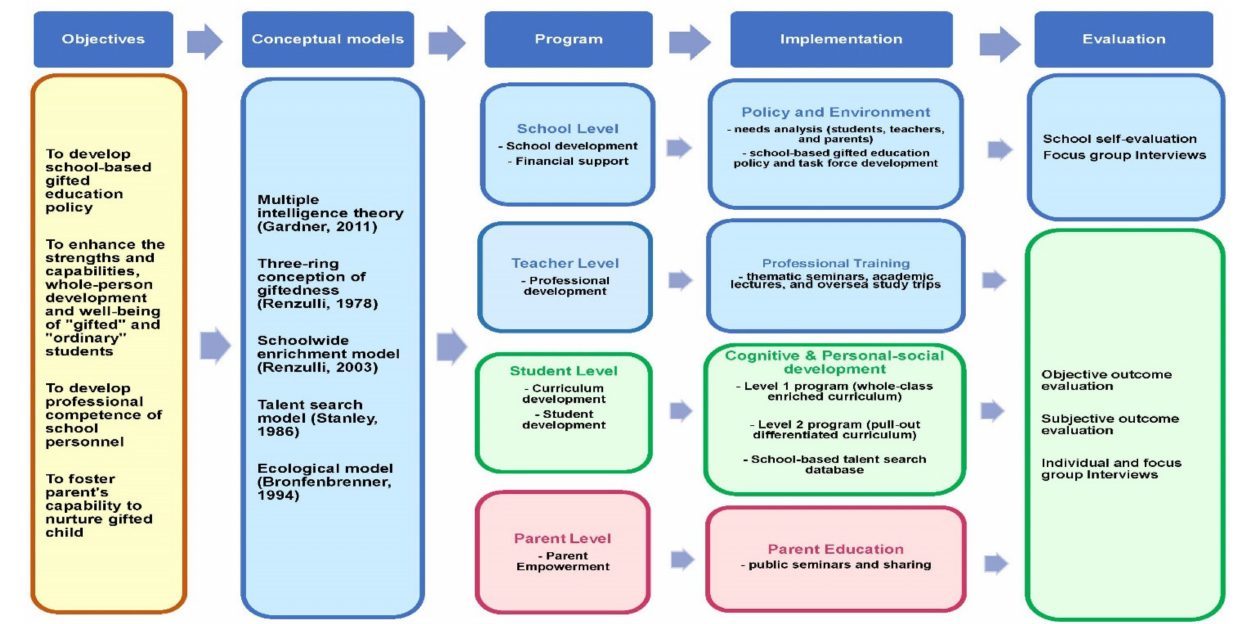
Figure 1. The intervention model of Project